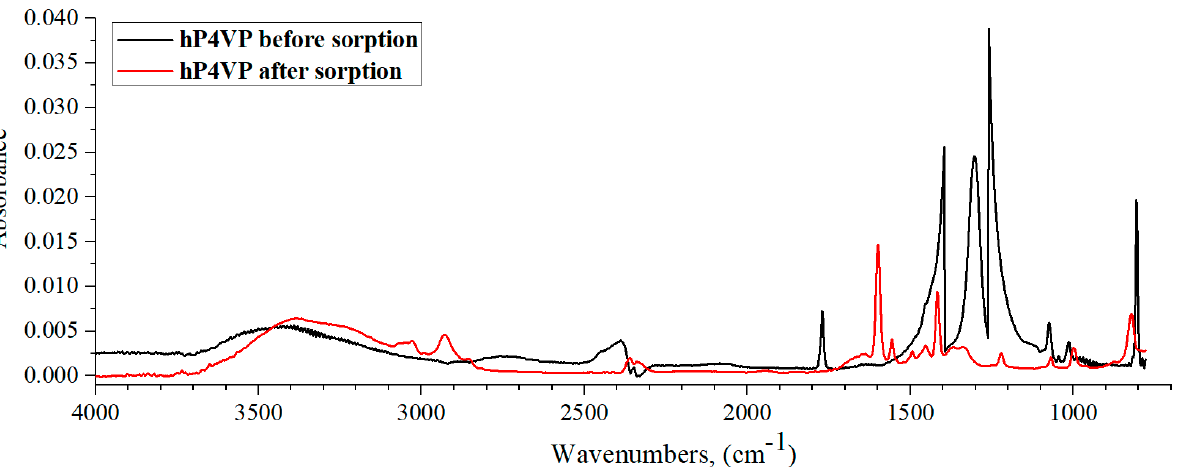
Figure 9. IR spectra of hP4VP before and after lanthanum sorption by interpolymer system 33%hPAA-67%hP4VP.